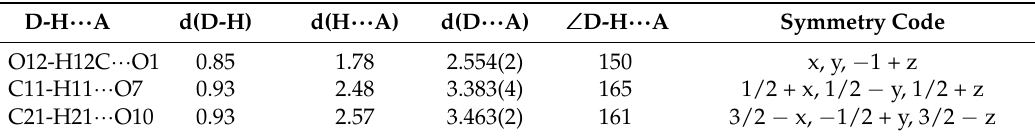
Table 4. The main hydrogen bonds [Å, ◦ ] for complex 1 .